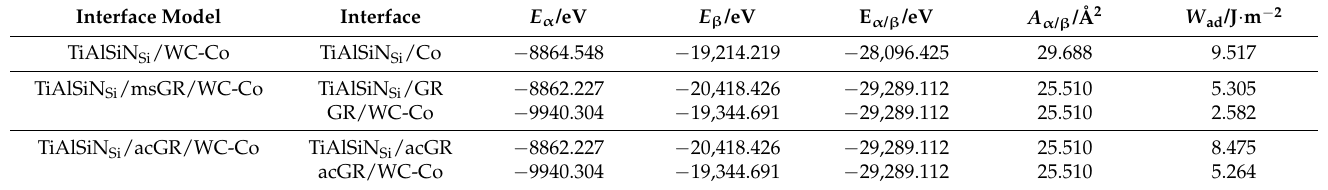
Table 6. Adhesion works of coating/matrix interface doped with intrinsic